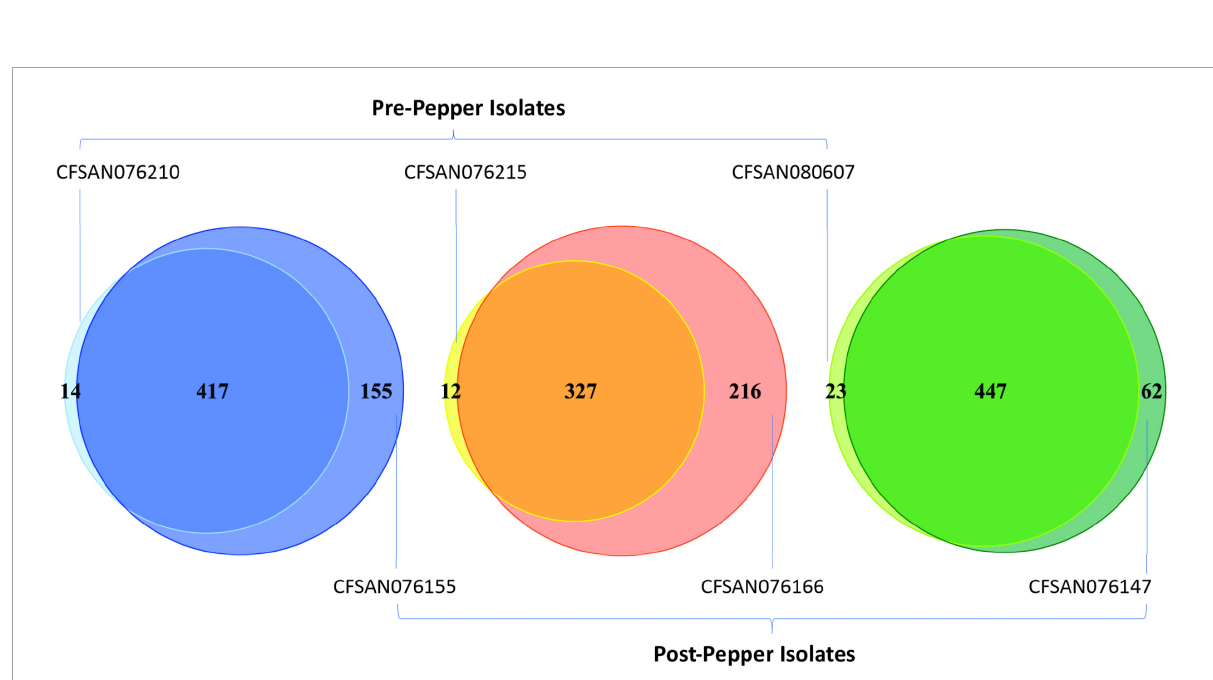
FIGURE2 Venn diagrams showing the number of BATGC m 6 AT motifs before and after immersion in black pepper for the three serovars (from left to right, Tennessee, Anatum, Reading). Most motifs remain methylated throughout storage in black pepper, and some additional motifs are